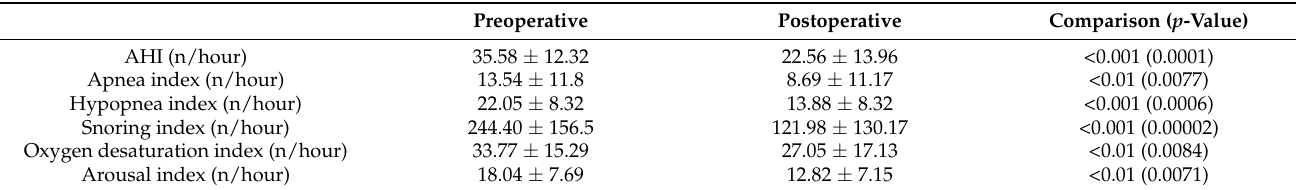
Table 1. Pre- and postoperative respiratory PSG-based parameters.